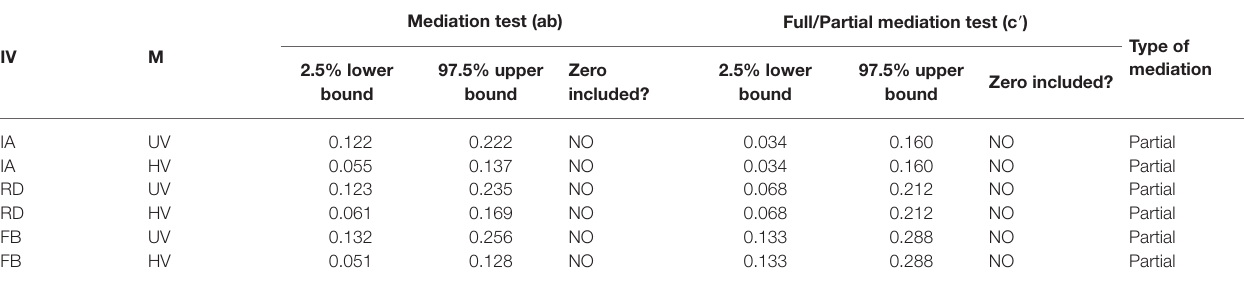
TABLE 5 | Mediating effects